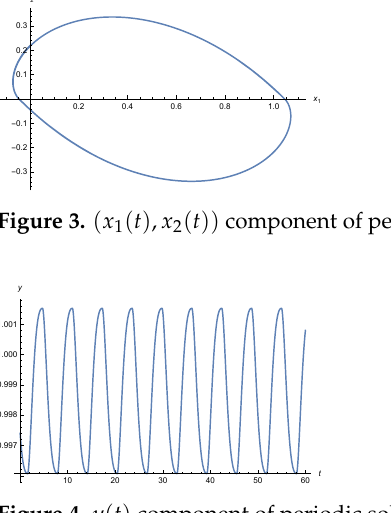
Figure 4. y ( t ) component of periodic solution of (55) with ε = 0.01.